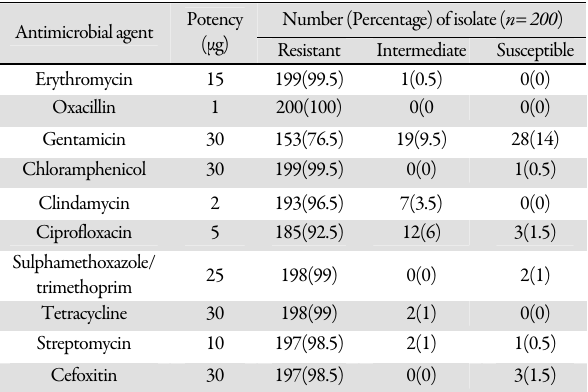
Table 3. Antibiogram of methicillin-resistant staphylococcal isolates from broilers